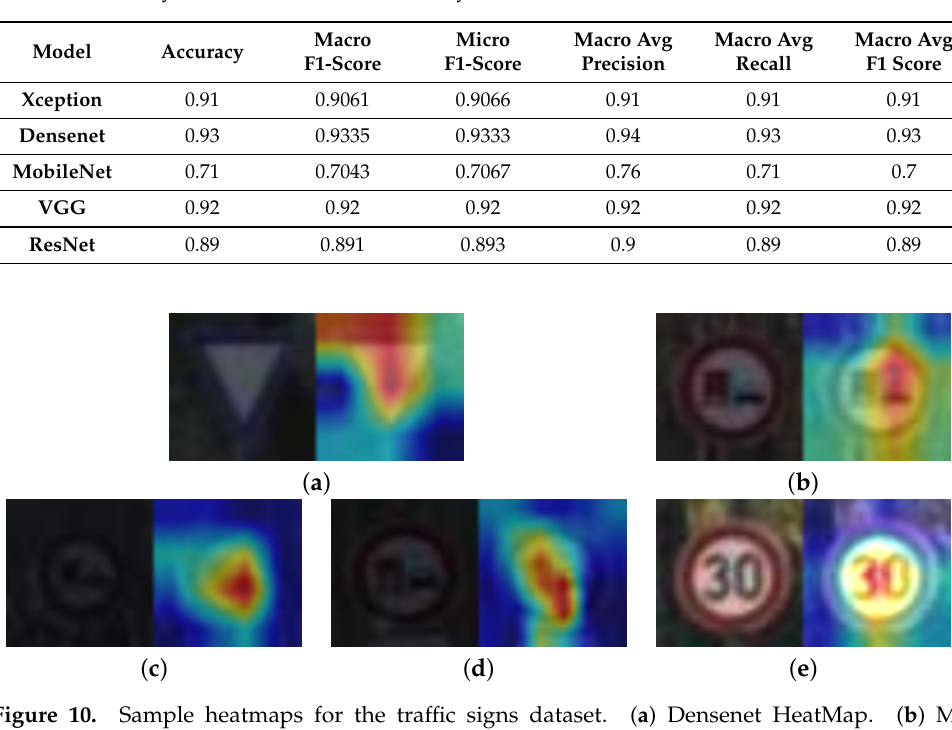
Figure 10. Sample heatmaps for the traffic signs dataset. ( a ) Densenet HeatMap. ( b ) Mo- bileNet HeatMap. ( c ) ResNet HeatMap. ( d ) VGG HeatMap. ( e ) Xception HeatMap.